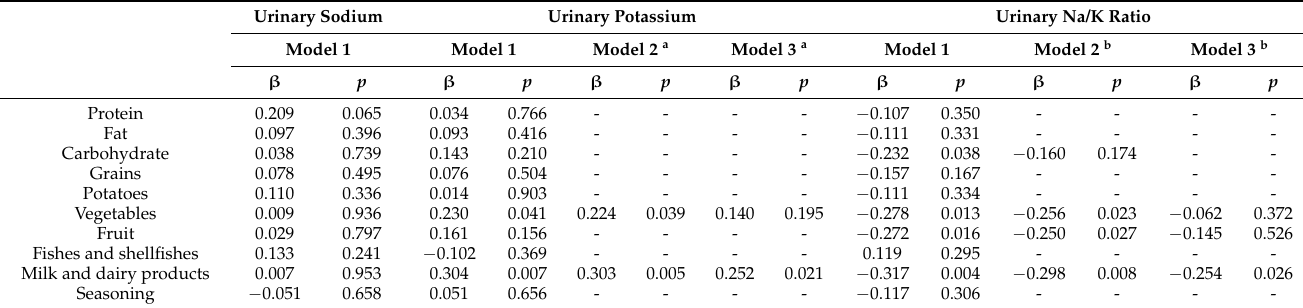
Table 4. Multiple regression model of urinary sodium, urinary potassium, and urinary Na/K